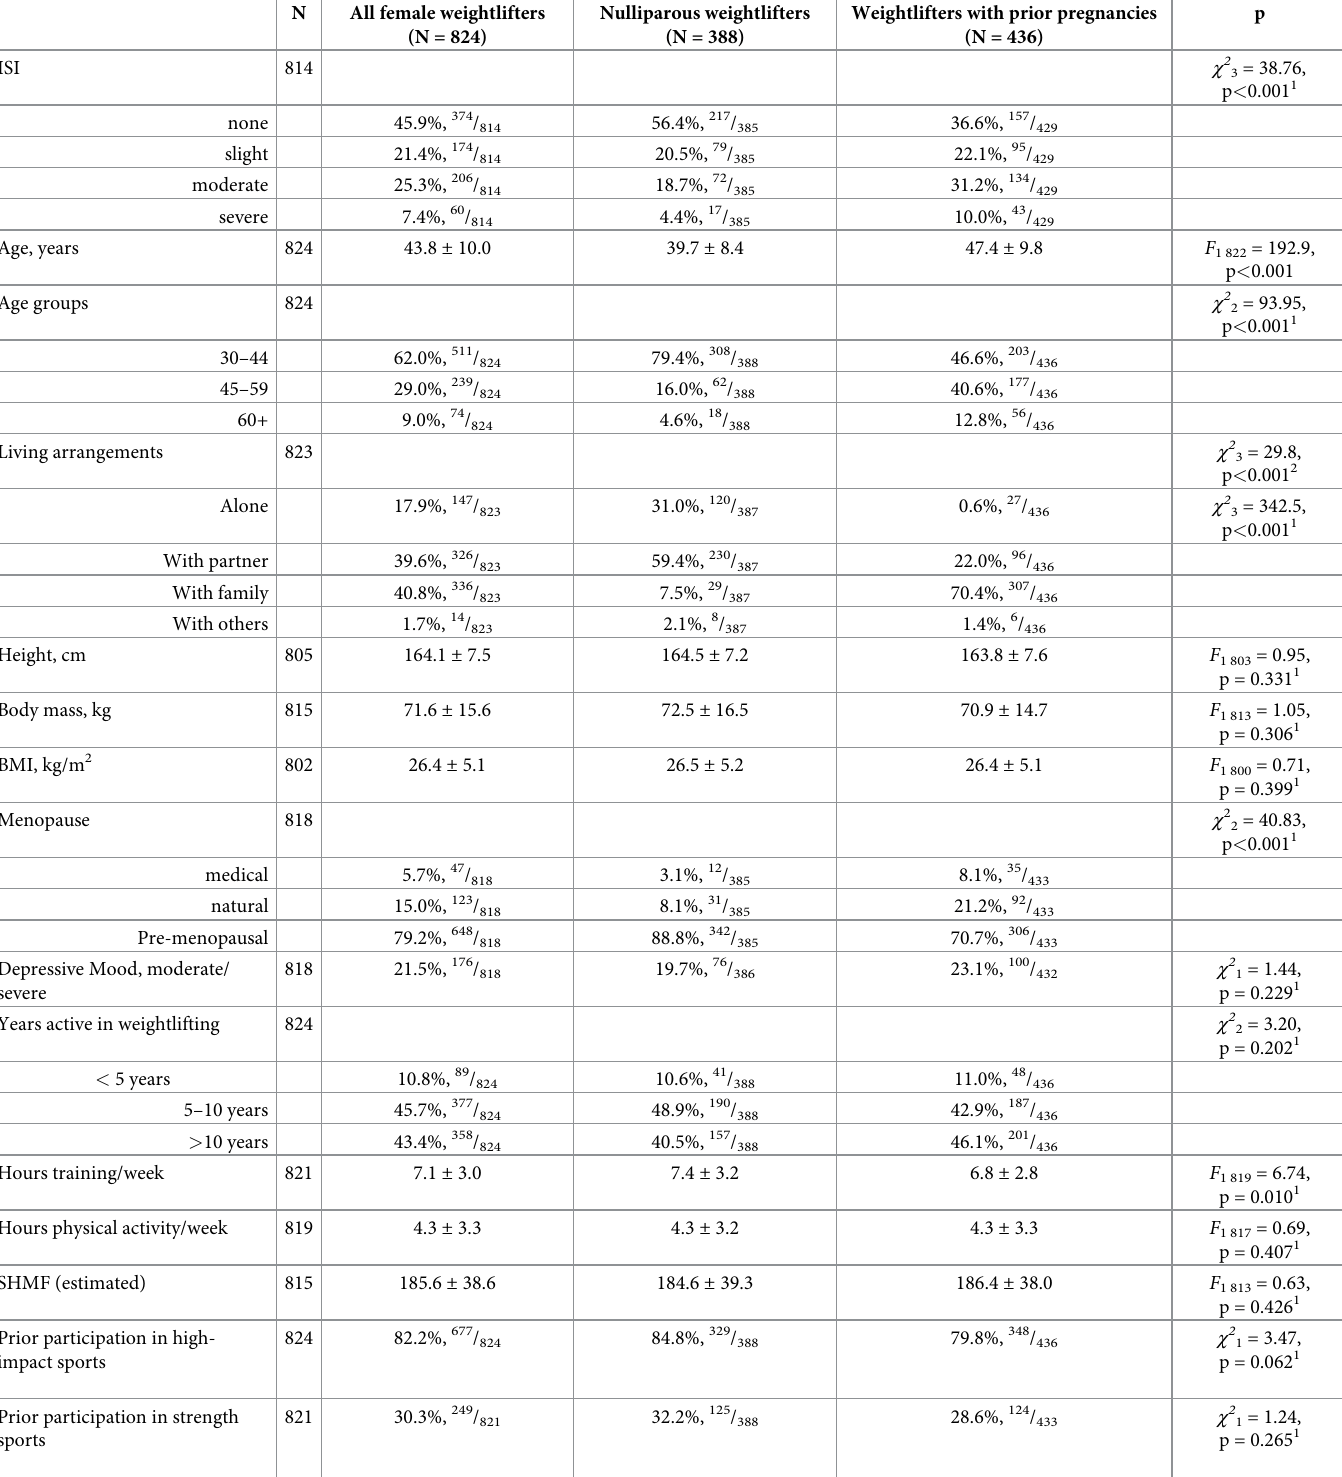
Table 1. Characteristics of respondents stratified by